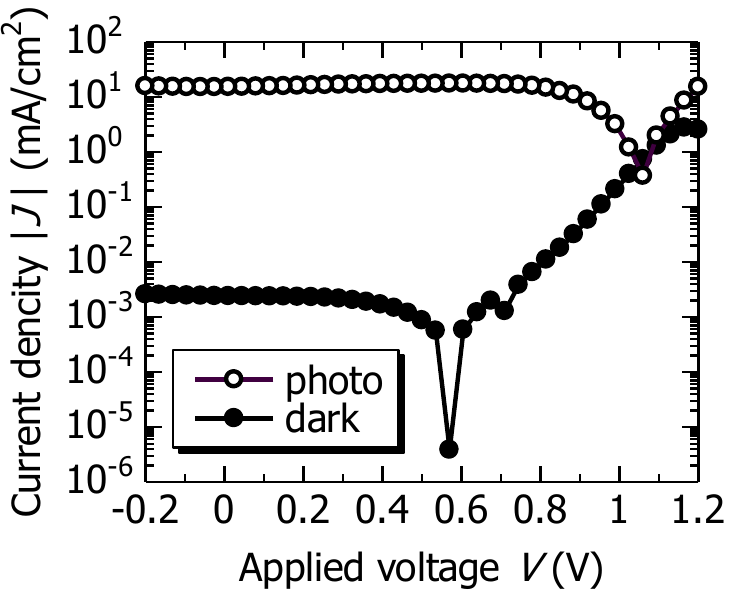
Figure 4. Current density versus voltage characteristics under dark and AM1.5 illumination for case of one-step method with TiO 2 layer fabricated by chemical bath deposition method.